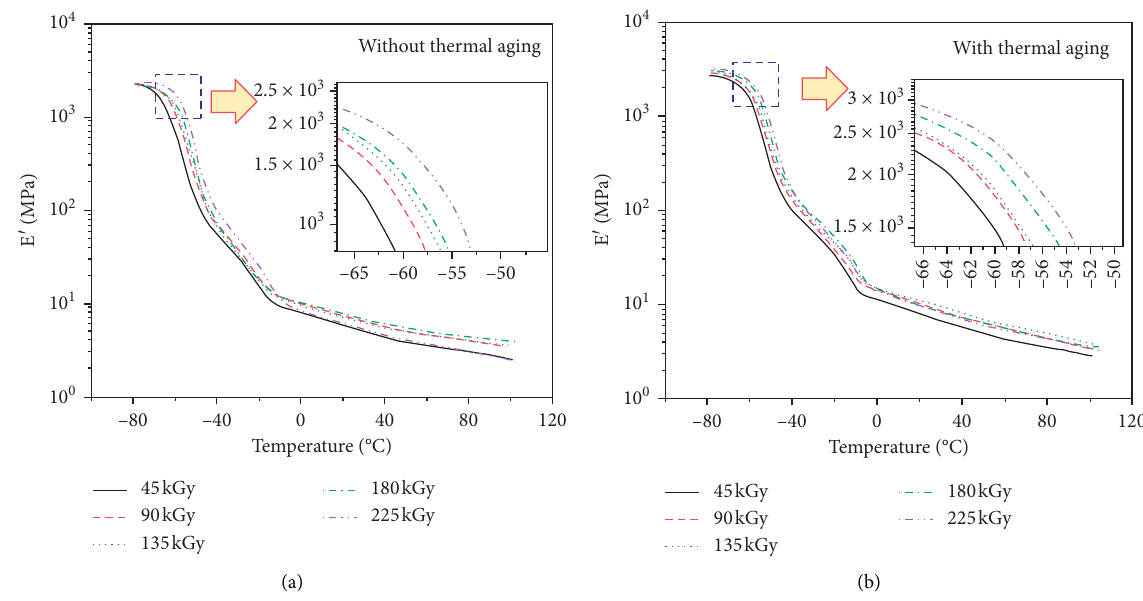
Figure 3: The E ′ of non-aged and aged BR/NR blends at different radiation